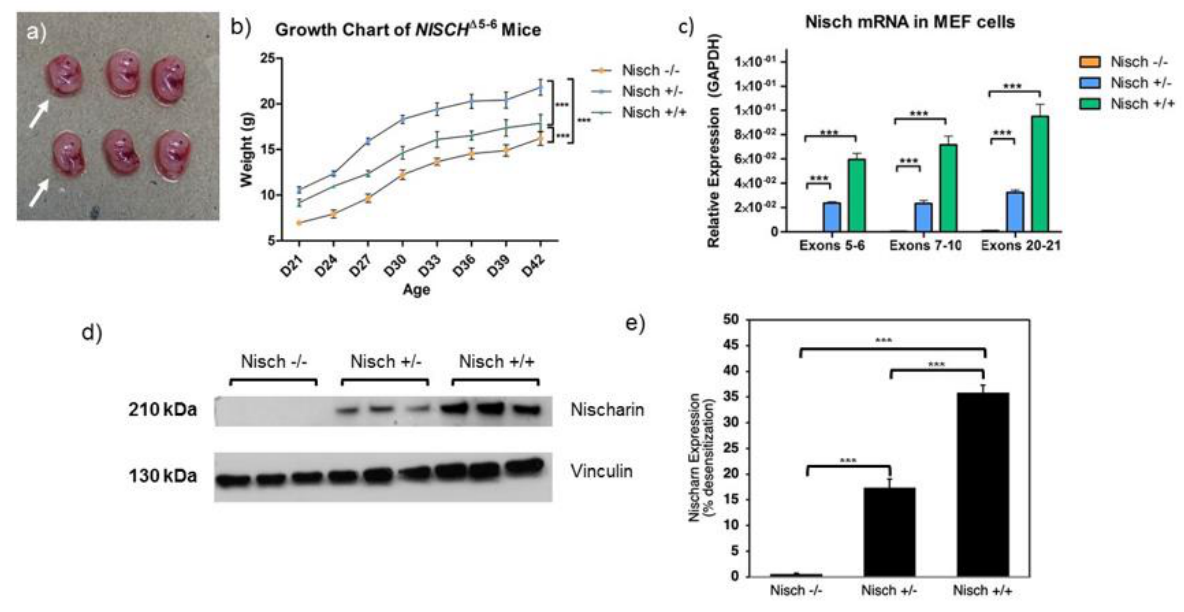
Figure 2. Knockout mouse phenotype shows attenuated growth. MEF cells were extracted as described in the Methods Section: ( a ) upon removal of the embryos from the amniotic sac, a slight difference in size is noted. The same phenotype has been shown in previous Nisch-mutated mouse models; ( b ) pups were measured for weight 3 weeks after weaning. Consistent with previous studies, Nisch − / − mice exhibited smaller sizes. Nisch +/ − mice were significantly larger, compared with Nisch +/+ mice; ( c ) three regions of the Nisch gene were tested for quantification of mRNA in the MEF cells: exons 5–6, exons 7–10, and exons 20–21. Each target gene’s expression levels were normalized to GAPDH. Data shown represent the mean ± SEM from the three independent experiments, each performed in triplicates; ( d ) Nisch − / − , Nisch +/ − , and Nisch +/+ cell lysates were obtained in triplicate repeats and run via SDS–PAGE for detection of Nischarin protein expression; ( e ) quantitation data of ( d ). Statistically significant values of *** p < 0001 were assigned using two-way t -test analysis between the three genotypes. Experiments were performed in triplicate and repeated two times.